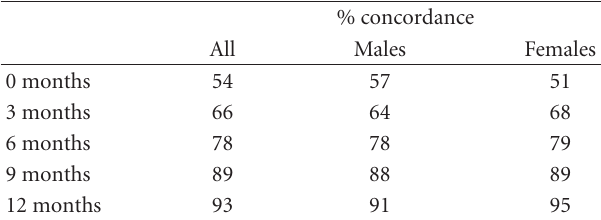
Table 2: Twin pair concordance for timing of MS colonization allowing 0, 3, 6, 9, and 12 months di ff erence between co-twins.